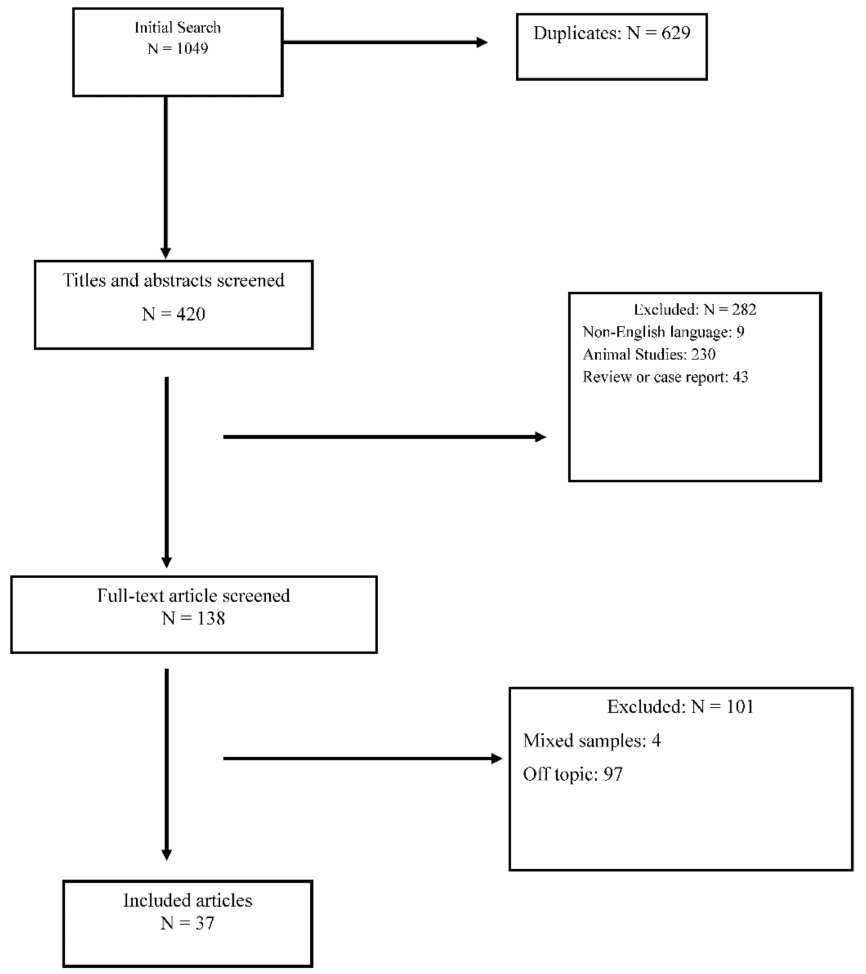
Figure 1. Prisma Diagram for